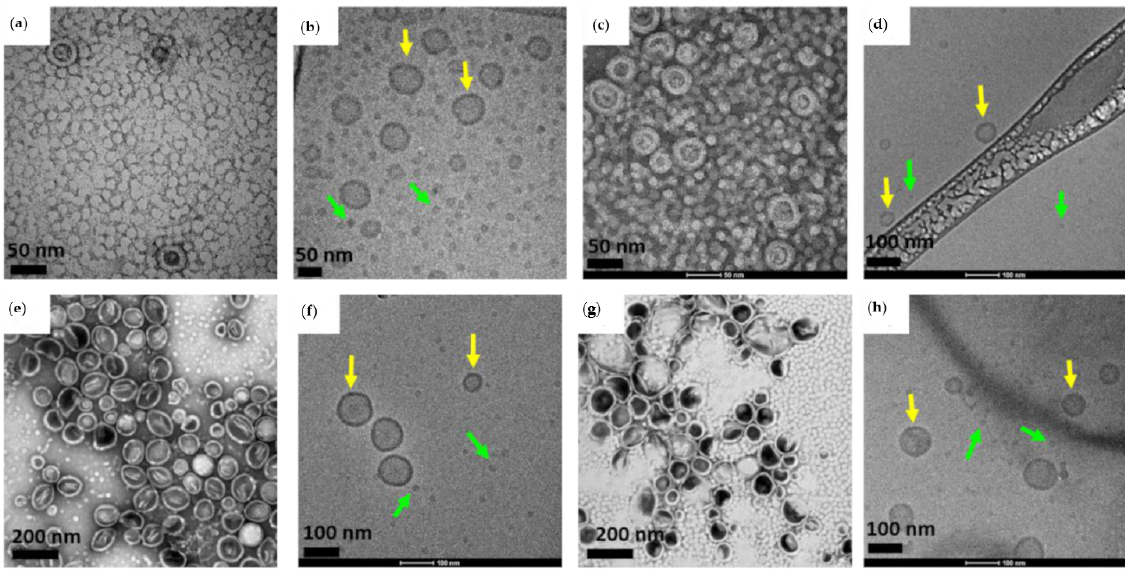
Figure 7. TEM images of ( a ) PEG 2k - b -d8DAP · thym-C 12 -thym, ( c ) PEG 2k - b -d8DAP · (thym-C 6 ) 4 -O, ( e ) PEG 2k - b - d16DAP · thym-C 12 -thym, and ( g ) PEG 2k - b -d16DAP · (thym-C 6 ) 4 -O; and cryo-TEM images of ( b ) PEG 2k - b -d8DAP · thym-C 12 - thym, ( d ) PEG 2k - b -d8DAP · (thym-C 6 ) 4 -O, ( f ) PEG 2k - b -d16DAP · thym-C 12 -thym and ( h ) PEG 2k - b -d16DAP · (thym-C 6 ) 4 -O self-assemblies (yellow arrows indicate vesicles and green arrows indicate micelles).